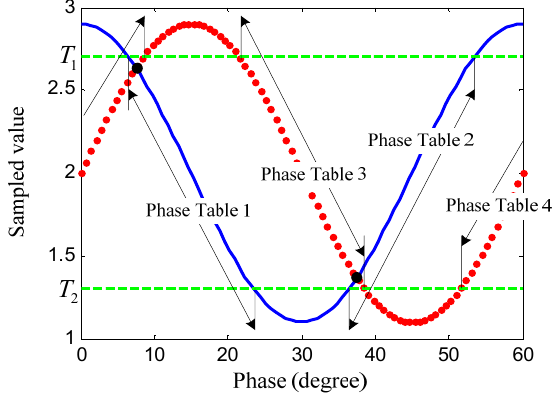
Figure 5. The sampled values of the difference signals in a tooth-slot